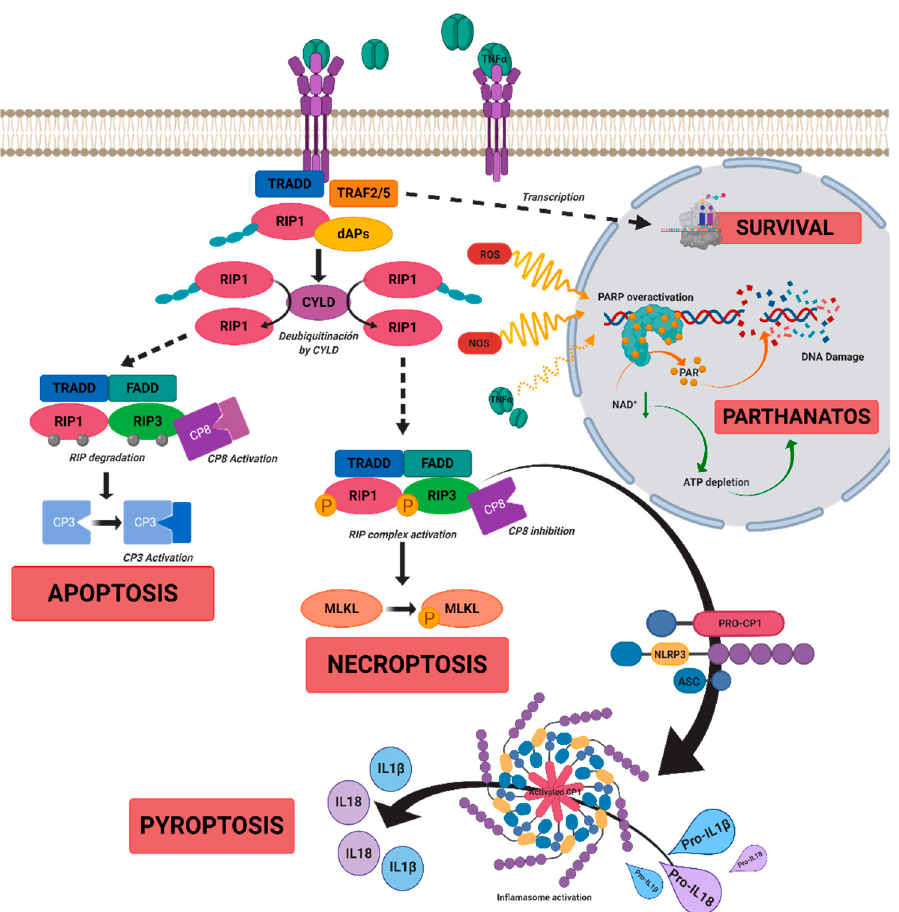
Figure 1. A scheme of possible cell death mechanisms during of tumor necrosis factor alpha (TNF α )-induced signaling in inherited retinal dystrophies (IRDs). TNF α can simultaneously activate multiple signaling pathways of cell death or survival. TNF α binds to tumor necrosis factor receptor 1 (TNFR1), triggering three functional states. (i) The intracellular domain of TNFR1 recruits a death-domain containing adaptor protein (TRADD). TRADD recruits TNF receptor-associated factor 2 (TRAF2) and receptor-interacting protein kinase 1 (RIPK1) to form Complex 1. Complex 1 seems to be important for nuclear factor kappa beta (NF- κ B)activation. NF- κ B regulates anti-apoptotic genes to block the initiation of apoptosis